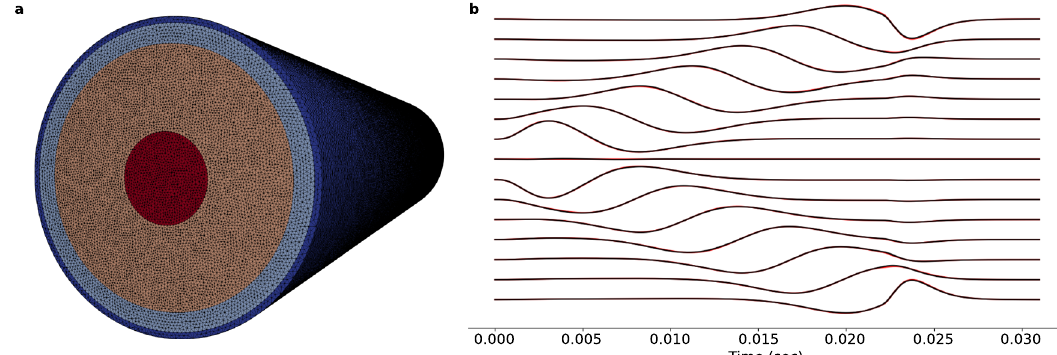
Fig. 2 | Comparison of the numerical and analytical solutions. a Tetrahedral mesh of the four layer cylindrical volume conductor. b Analytical 23 (red) and numerical (black) EMG signals for a differential array electrode montage. The depth of the source fi bre in this example is 1 mm from the muscle